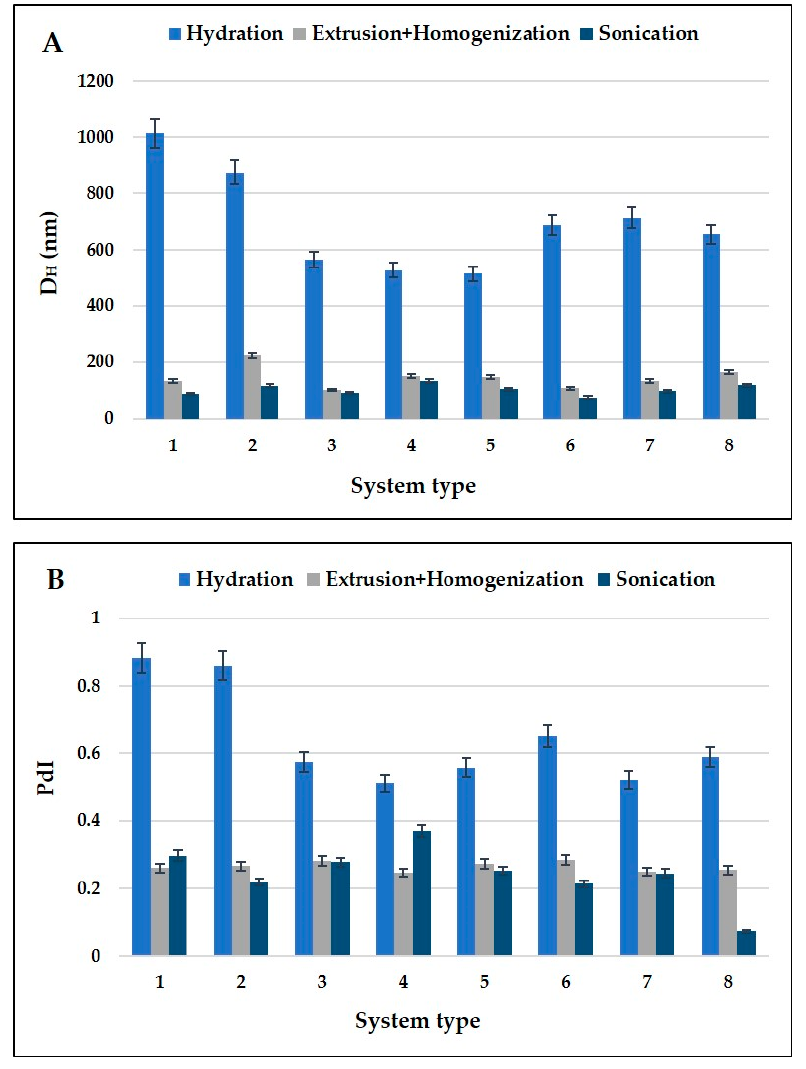
Figure 1. Influence of the modified liposomes preparation methods on the ( A ) vesicle size (D H ) and ( B ) polydispersity index (PdI).